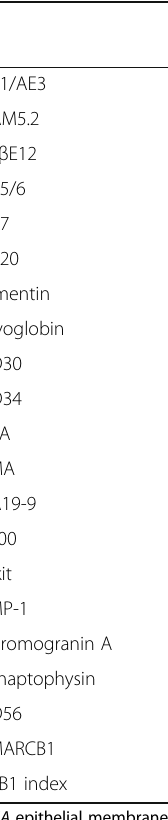
Table 2 Results for